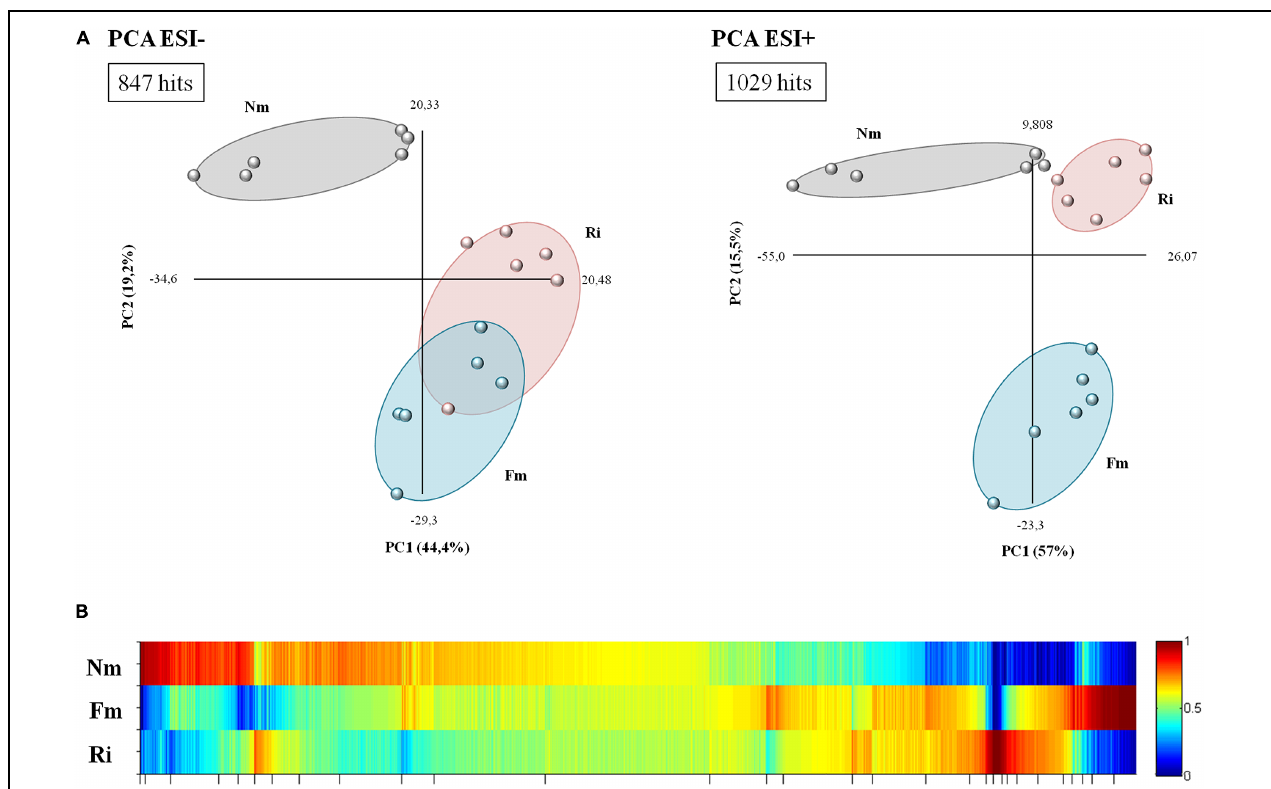
FIGURE 2 | Overview of metabolite behavior in non-mycorrhizal (Nm) and mycorrhizal roots interpreted using principal component and heat map analysis. (A) Analysis of major sources of variability of ESI − and ESI + signals obtained from a non-targeted analysis by HPLC–QTOF MS monitoring metabolomic changes in roots colonized by F. mosseae (Fm) or R. Irregularis (Ri). Data points represent six replicates per treatment injected randomly into the HPLC–QTOF MS. The identified signals corresponding to different treatments were compared using the non-parametric Kruskal–Wallis test, and only data with a p < 0.1 between groups were used for a